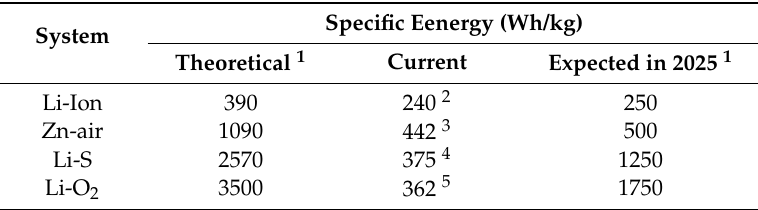
Table 1. Specific energy of current and future chemical battery